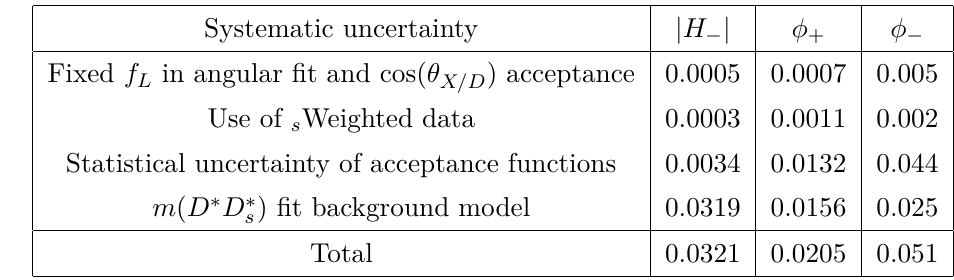
Table 1 . Systematic uncertainties on the branching fraction ratios and f L as measured in the ) fit. m ( D ∗− D + s